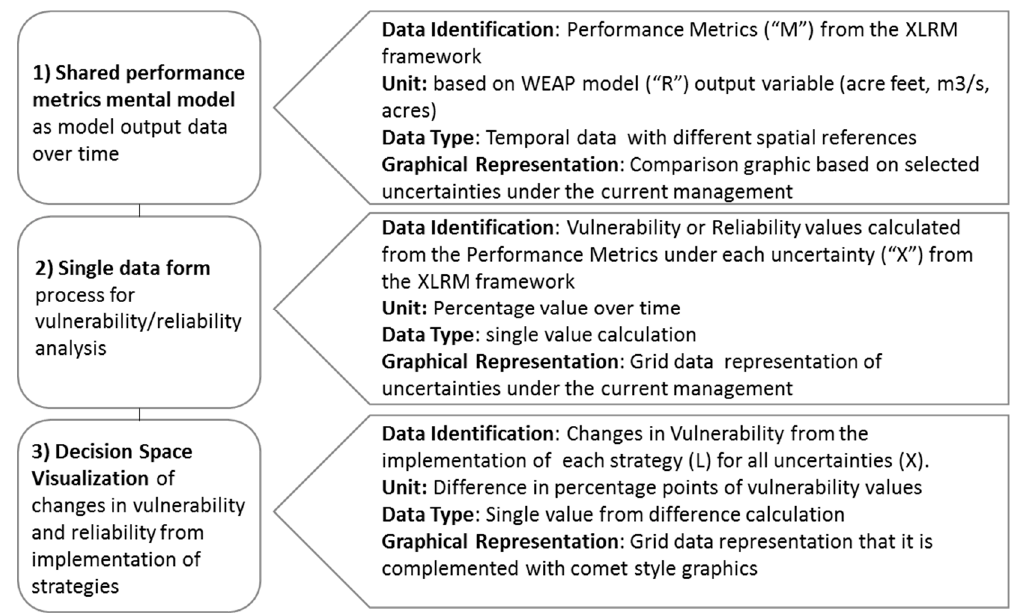
Figure 2. Visualization Process from [32].